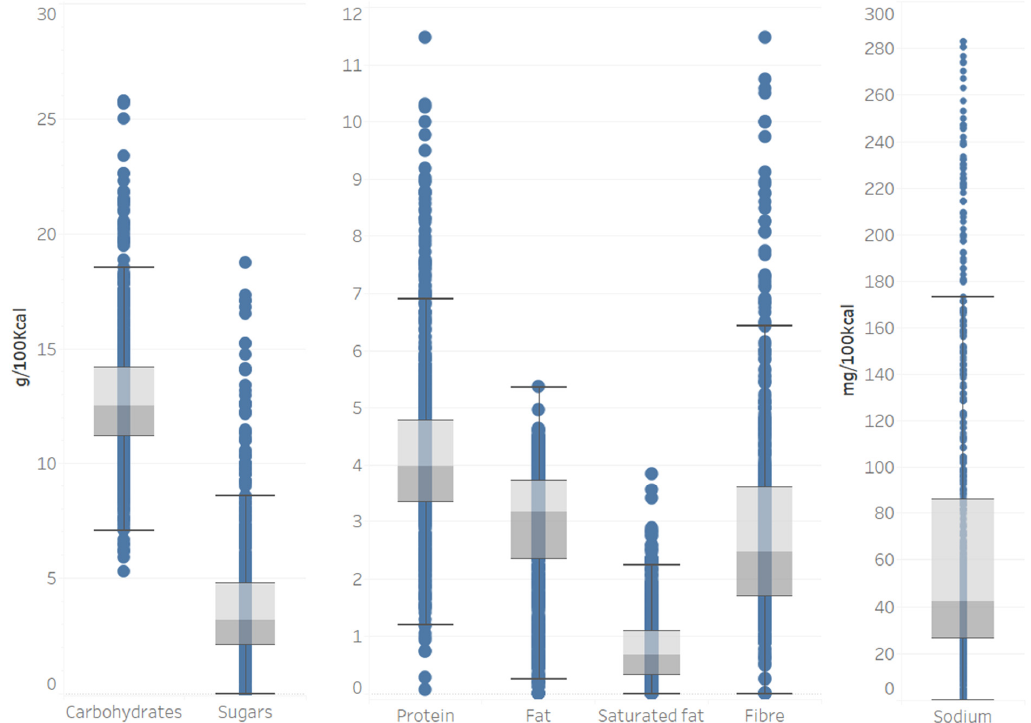
Figure A7. Nutrient content (g/100 kcal product, except for sodium mg/100 kcal product) of ‘Baby savoury meals and